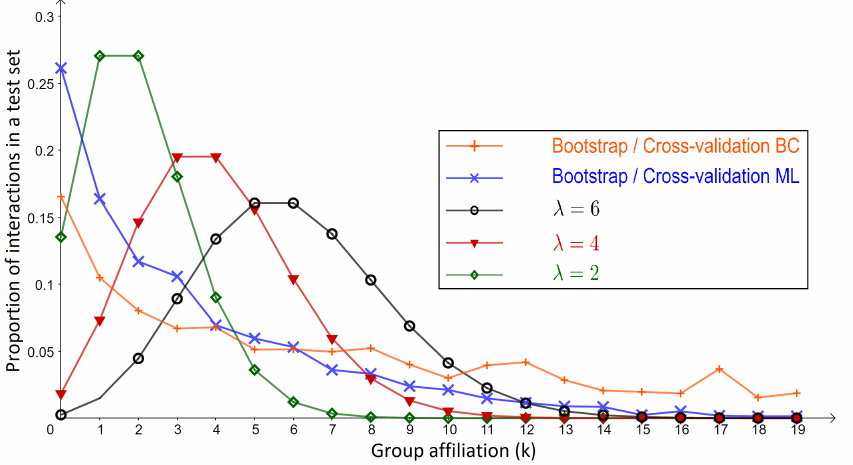
Figure 1. Proportion of interactions, related to items of group k , in the test set (ML and